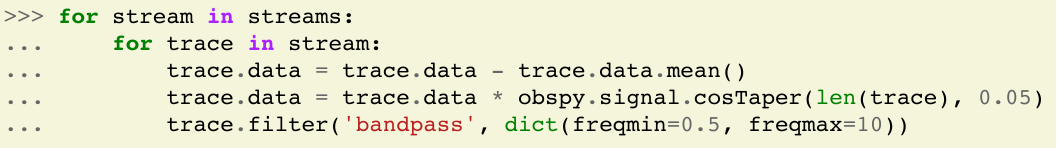
Figure 9. Example code: Looping over a list of streams and de-meaning, tapering and filtering all of the traces in every